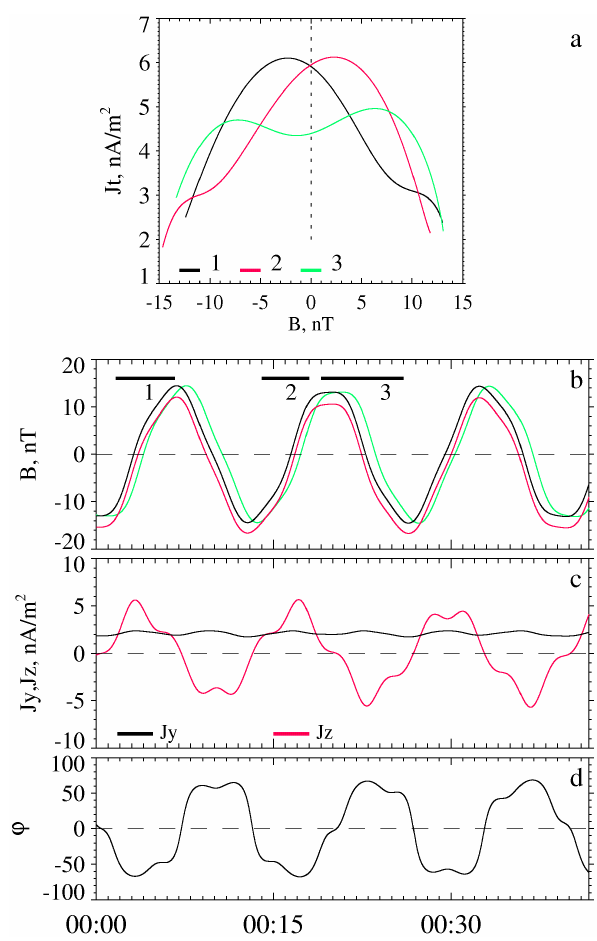
Fig. 5. Model current sheet with two monochromatic waves. (a) Current density profiles for three individual crossings. (b) Mag- netic field B x . Colors denote three virtual satellites (see text for positions). (c) J y (black) and J z (red) current density. (d) φ , tilt of the normal in the YZ plane. The time axis is in hh:mm format (arbitrary time). Thick horizontal black lines in panel (b) denote the intervals of the profiles in